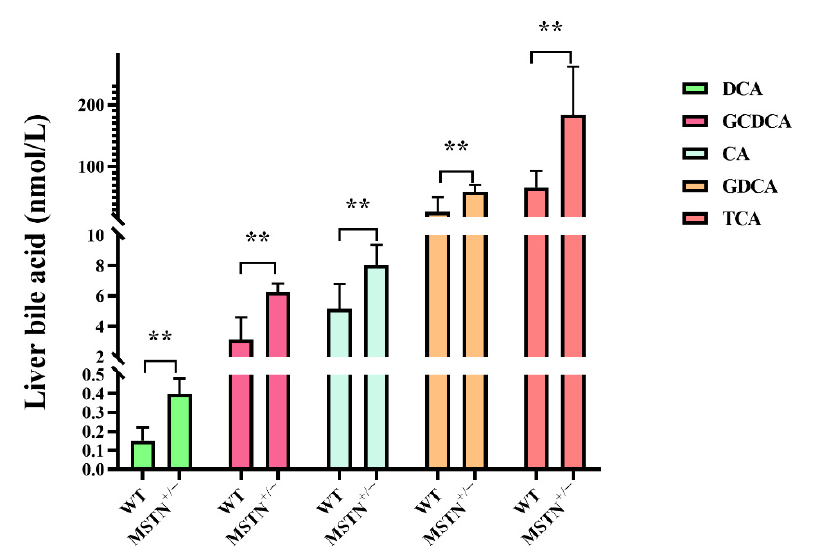
Figure 4. Targeted metabolomics analysis identifies the alteration of bile acid in the liver of MSTN +/ − and WT cattle. Differentially expressed bile acid species were identified in the liver. ** p < 0.01. WT, wild type; MSTN +/ − , MSTN heterozygous deletion. Abbreviations: DCA, deoxycholic acid; GCDCA,